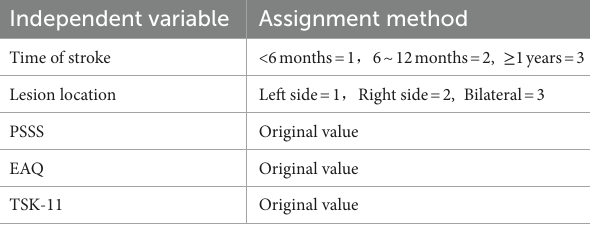
TABLE 3 Assignment of independent